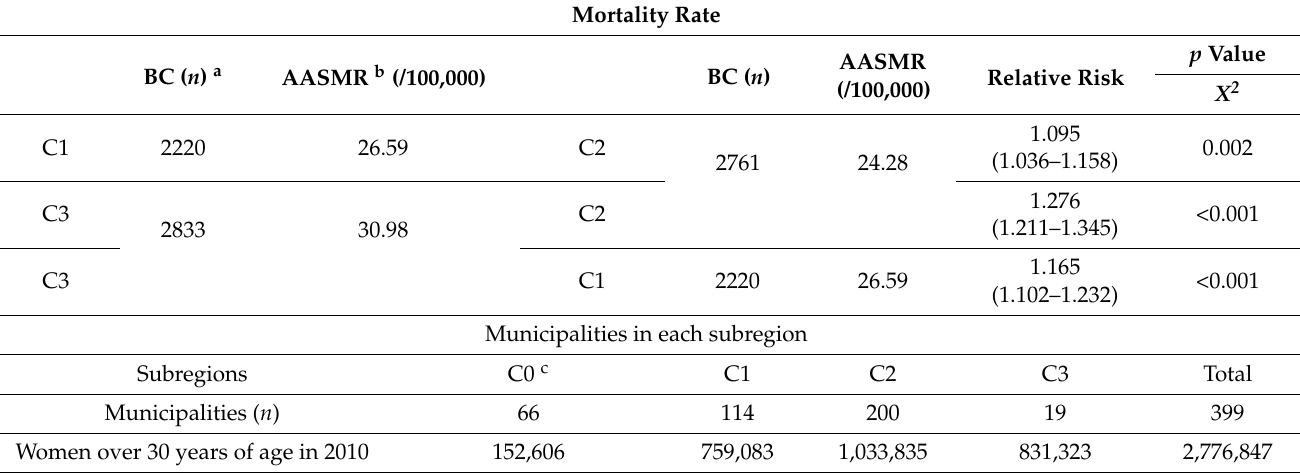
Table 4. Mortality rate and municipalities in the subregions of Paran á state (2005–2015). Mortality